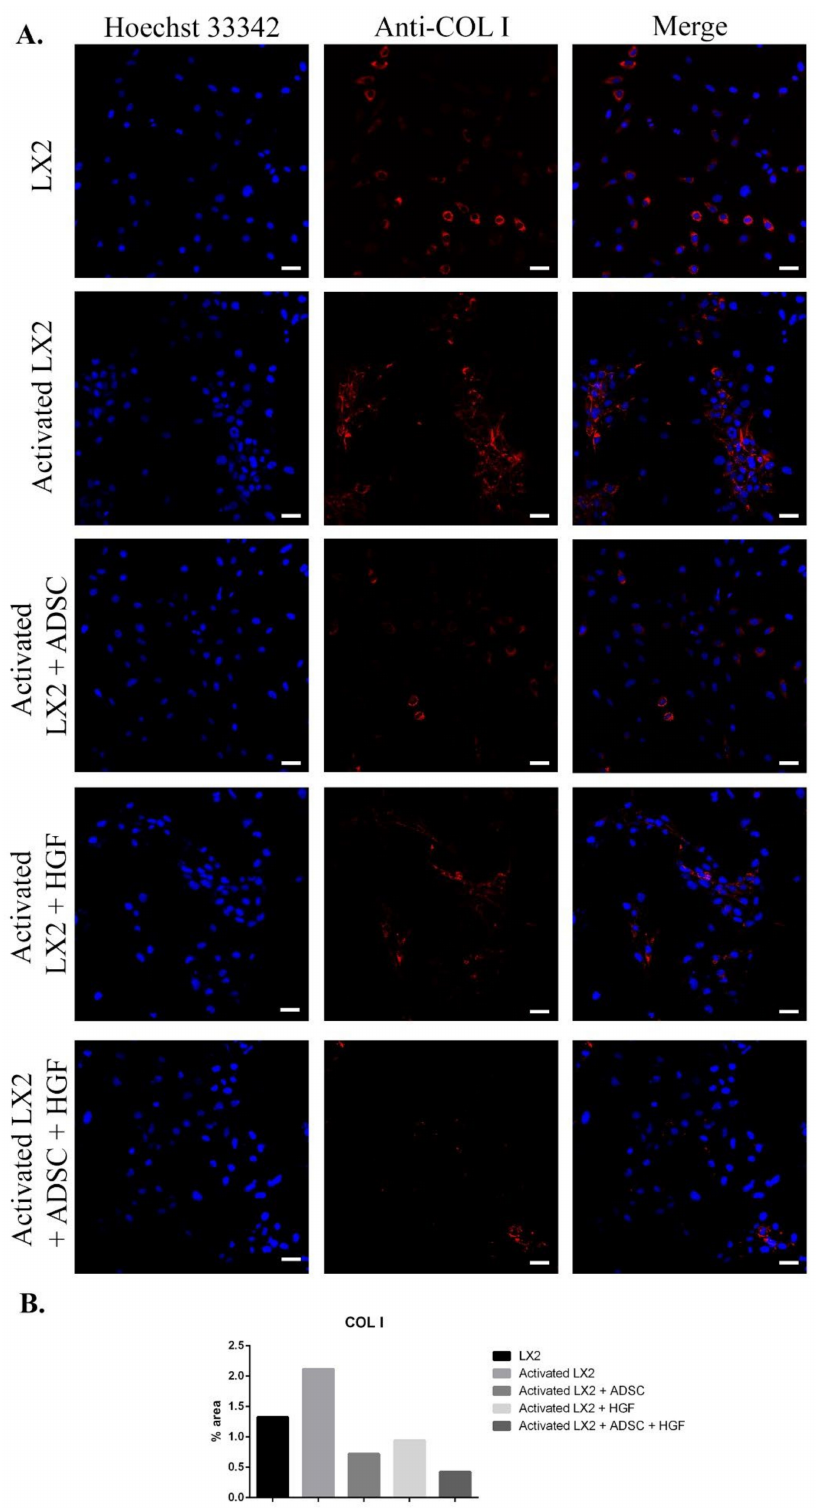
Figure 3. Evaluation of collagen type I (COL I) expression in the following conditions: LX2, activated LX2 (induced with TGF- β 1), activated LX2 + ADSC (activated LX2 cocultured with ADSCs), activated LX2 + HGF (activated LX2 treated with HGF), activated LX2 + ADSC + HGF (activated LX2 cocultured with ADSC, treated with HGF). ( A ). Immunofluorescence staining of COL I (antibody conjugated with AF-546, red), nuclei of the cells stained with Hoechst 33342 (blue); ( B ) quantification of the immunofluorescence staining of COL I; scale bar: 50 µ